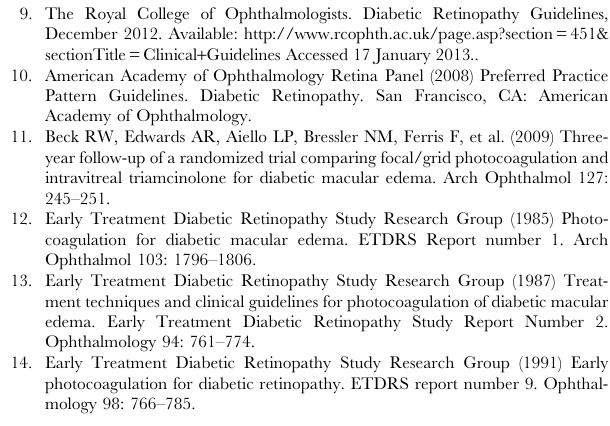
Table S3 Studies from randomized controlled trial database search excluded based on full text review. Table S4 Quality appraisal of included systematic